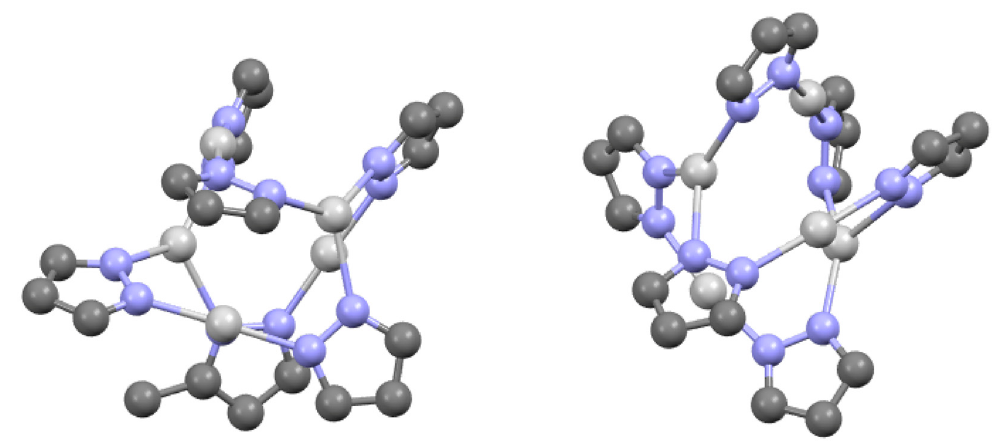
Figure 8. A view of the two independent molecules of SOJCUS. Only the silver atoms and the pyrazolate rings are represented.